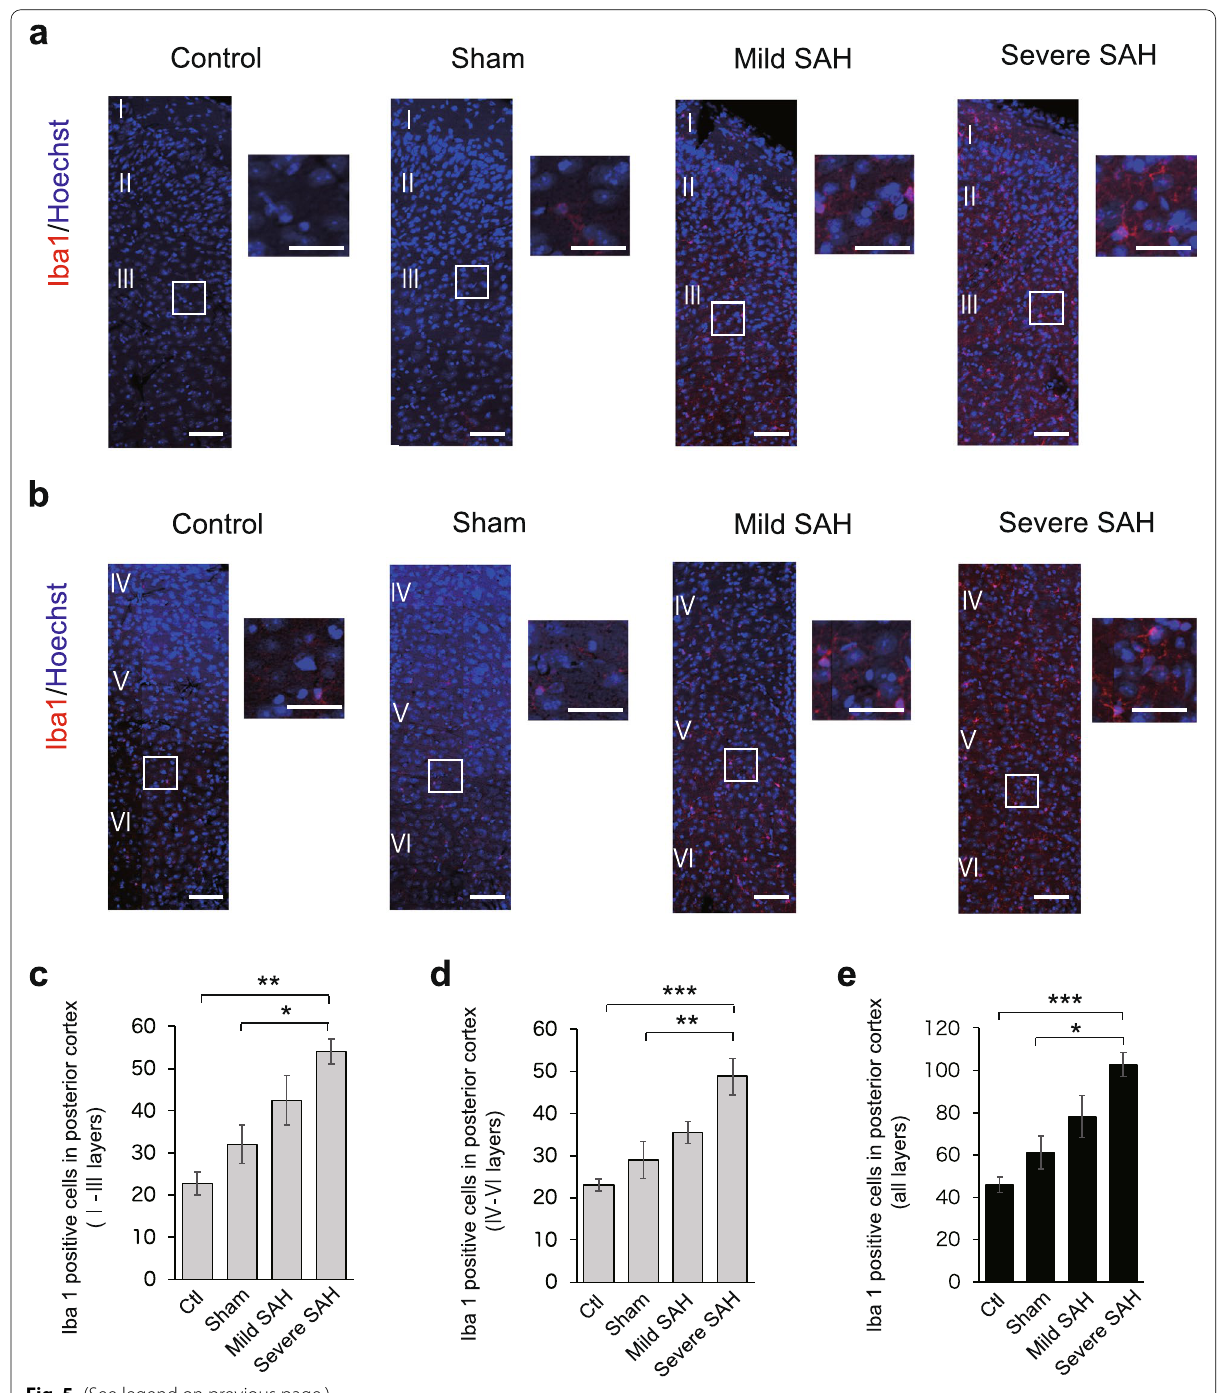
Fig. 5 (See legend on previous